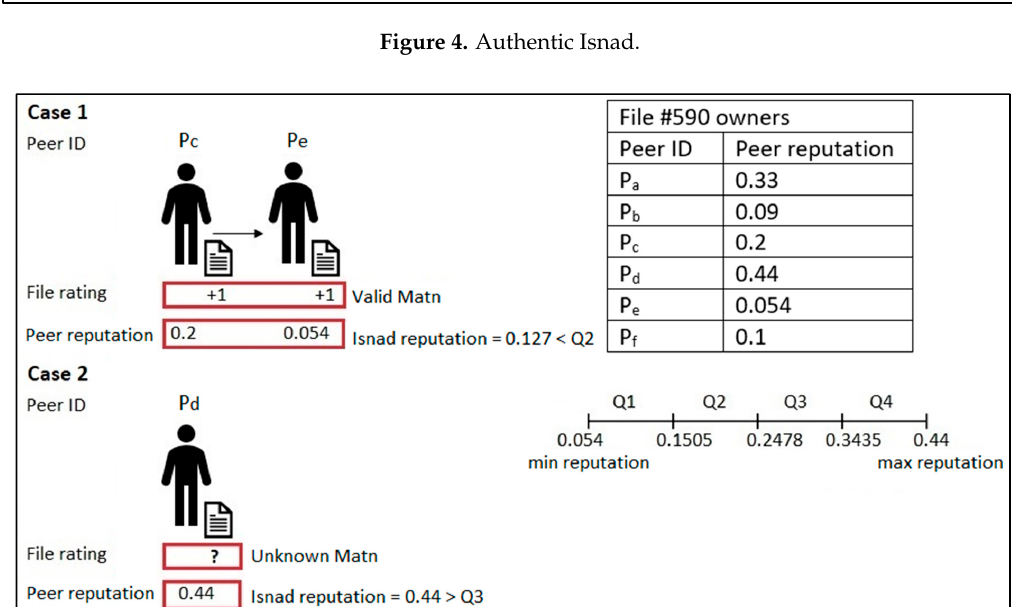
Electronics 2021 , 10 , x FOR PEER REVIEW